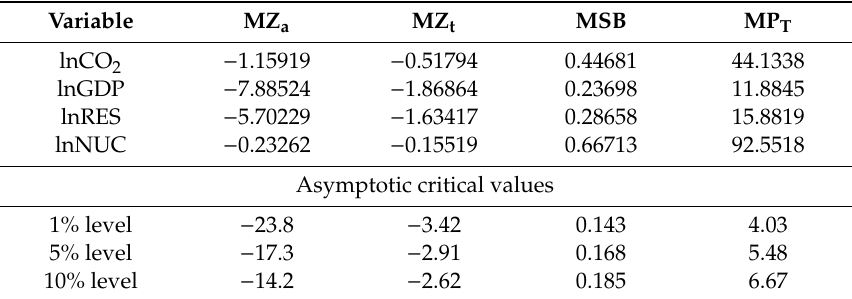
Table 1. The Ng-Perron unit root test results for levels of